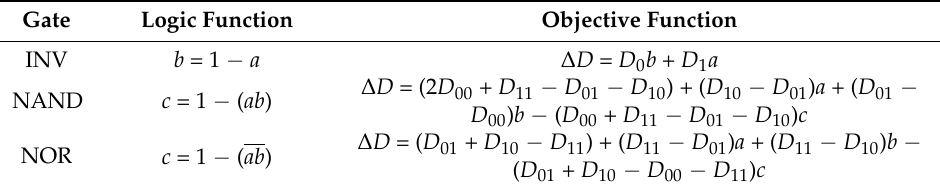
Table 1. ILP objective function for delay degradation of logic gates.